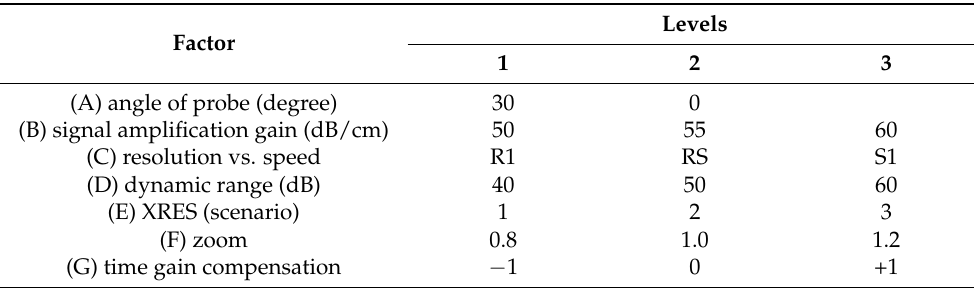
Table 2. Seven factors (each bearing two or three levels) used in the proposed ultrasound scan protocol, according to Taguchi’s settings in Table